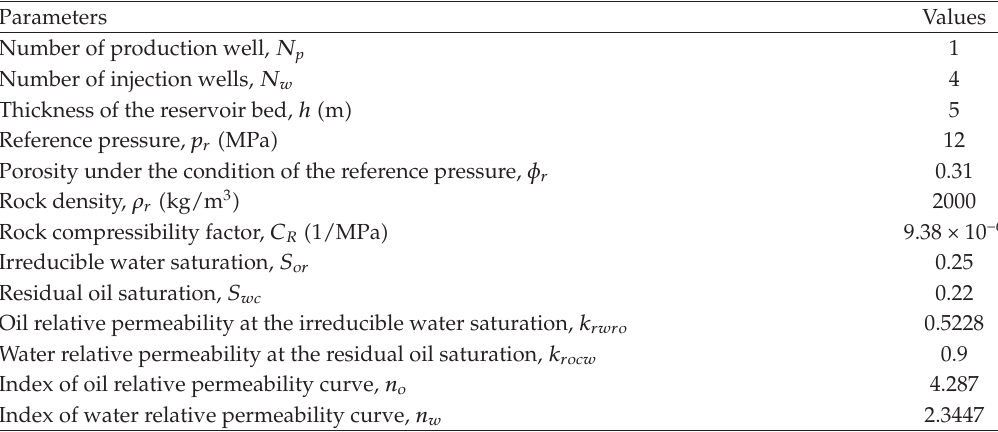
Figure 3: Initial reservoir pressure (cid:2) MPa (cid:3) contour map. Table 1: Parameters of reservoir description used in the